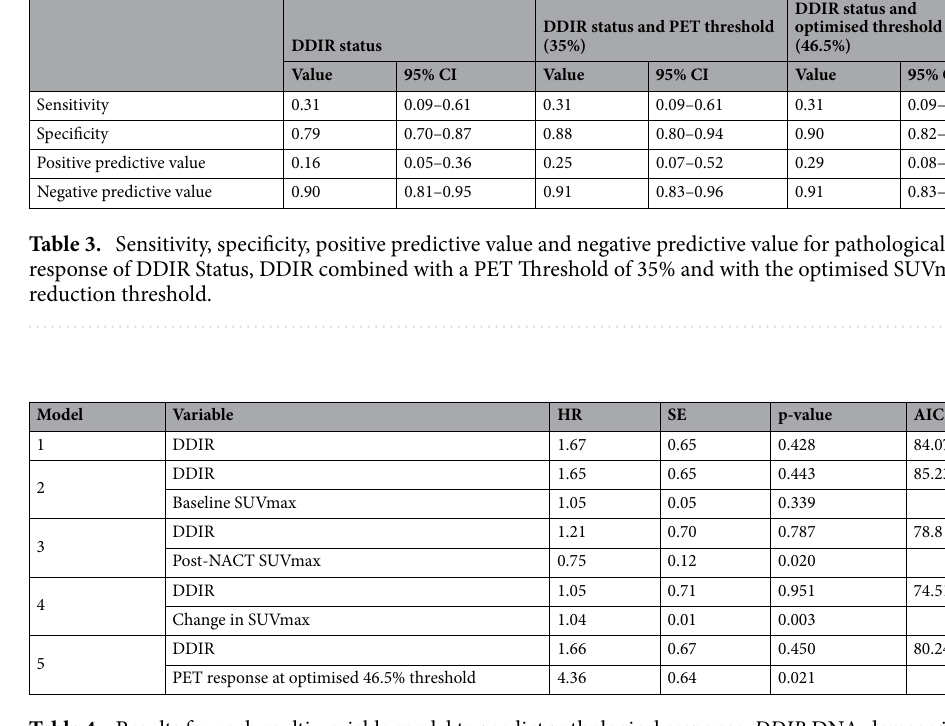
Table 4. Results for each multi-variable model to predict pathological response. DDIR DNA-damage immune response, NACT neo-adjuvant chemotherapy, SUVmax maximum standardised uptake value, HR hazard ratio, SE standard error, AIC Akaike Information